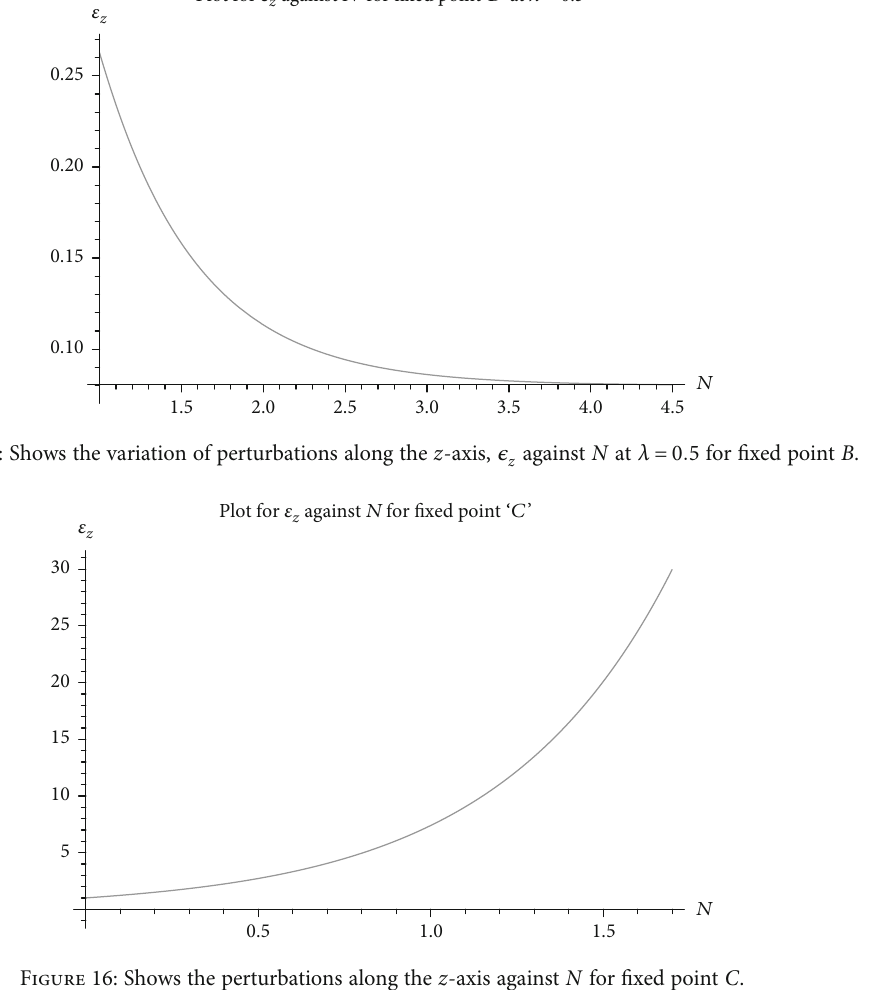
ffiffiffiffiffi p λ ′ = 12 α x λ : ð 24 Þ